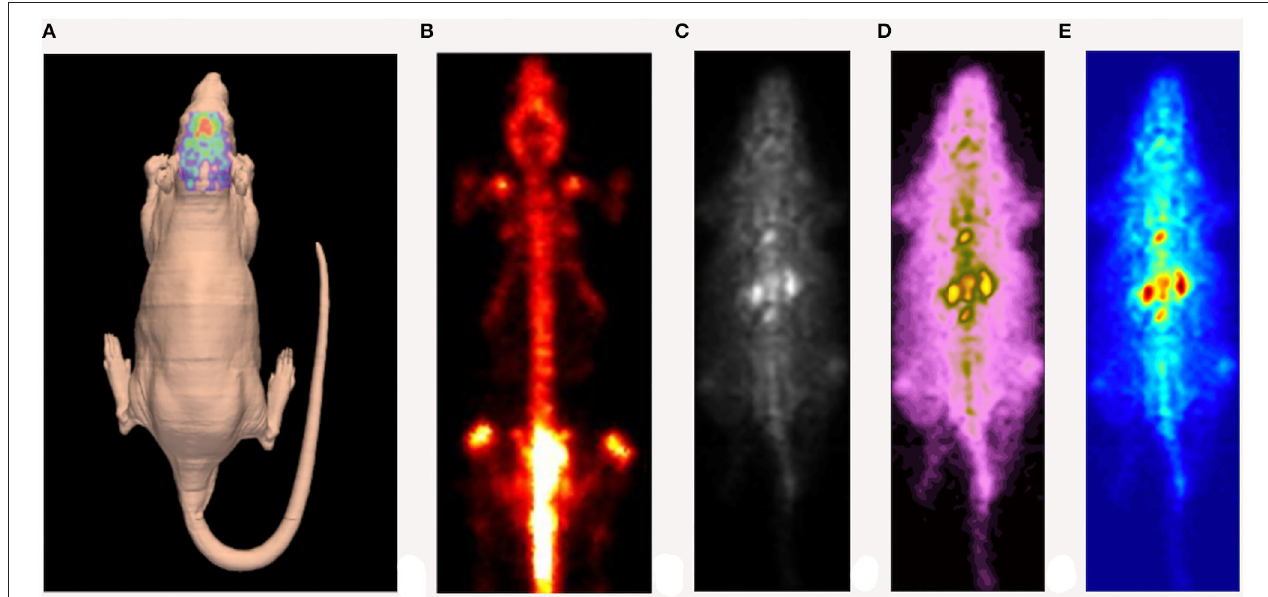
FIGURE 3 | Example of high-resolution SPECT image of a rat injected with [ 123 I] DATSCAN. (A) Reconstruction of the animal’s skin carried out by a laser scanner. (B) SPECT image obtained 24h after the injection. (C–E) Early SPECT image obtained ∼ 1h after the injection (different color